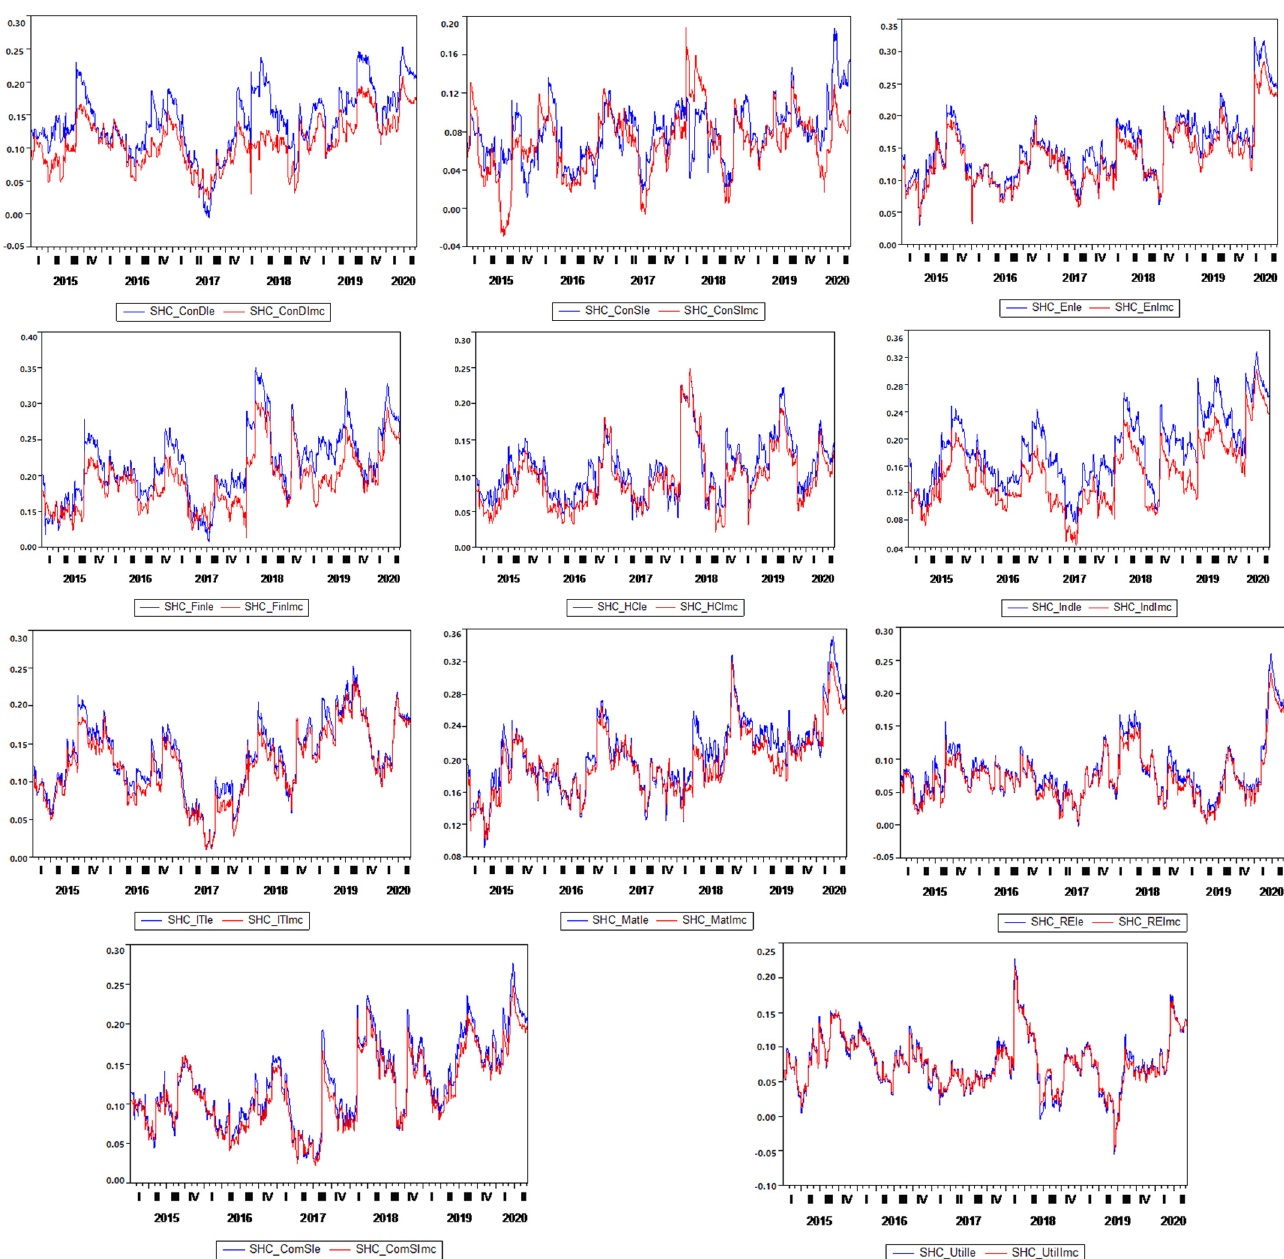
Figure 2. Dynamic conditional correlations of various Australian sectors and the Shanghai Composite Index (SHC). Note: For all graphs, the x -axis shows the time and the y -axis shows the dynamic conditional correlations between varies Australian Sectors and the SHC. The dynamic conditional correlation financially integrated generalized autoregressive conditional heteroskedasticity (DCC-FIGARCH) model coefficients are presented in Appendix B.